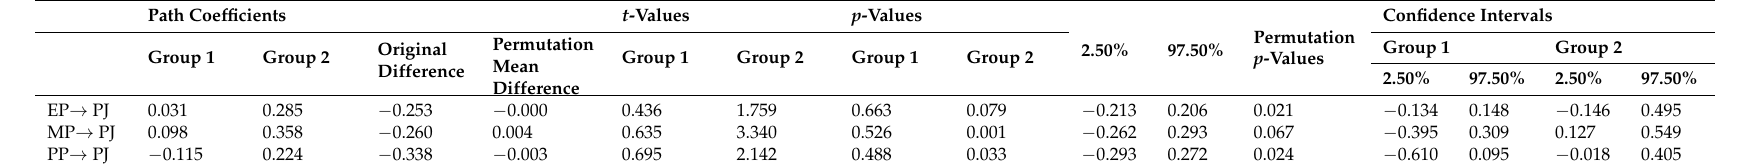
Table 8. Permutation test path coefficient results and Multigroup Comparison